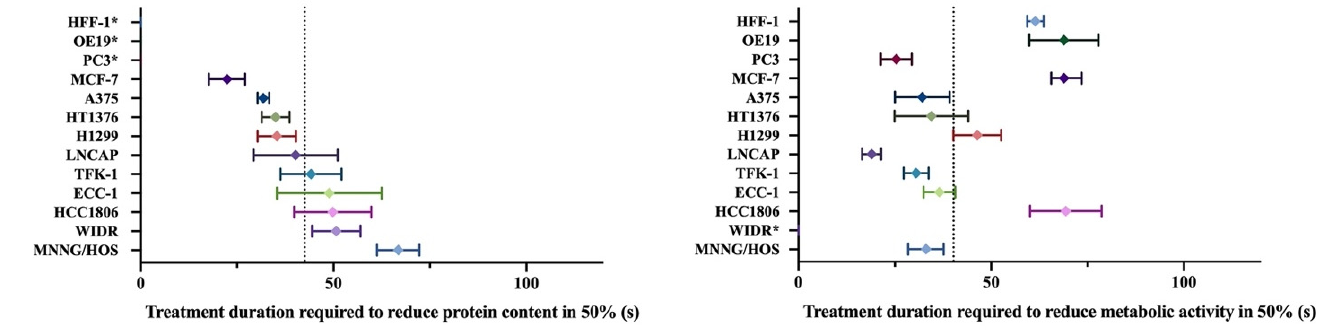
Figure 5. Comparison of the cytotoxic effect of cold atmospheric plasma in different cell lines. ( a ) Comparison of the calculated exposure time required to decrease protein content by half (IT50) as assessed by SRB. ( b ) Comparison of the calculated exposure time required to decrease the metabolic rate by half (IT50) as assessed by MTT. Confidence intervals of 95% are represented by the horizontal bars. The calculated average IC50s of all cell lines are represented as a vertical bar in each figure. *: IT50 not computable.